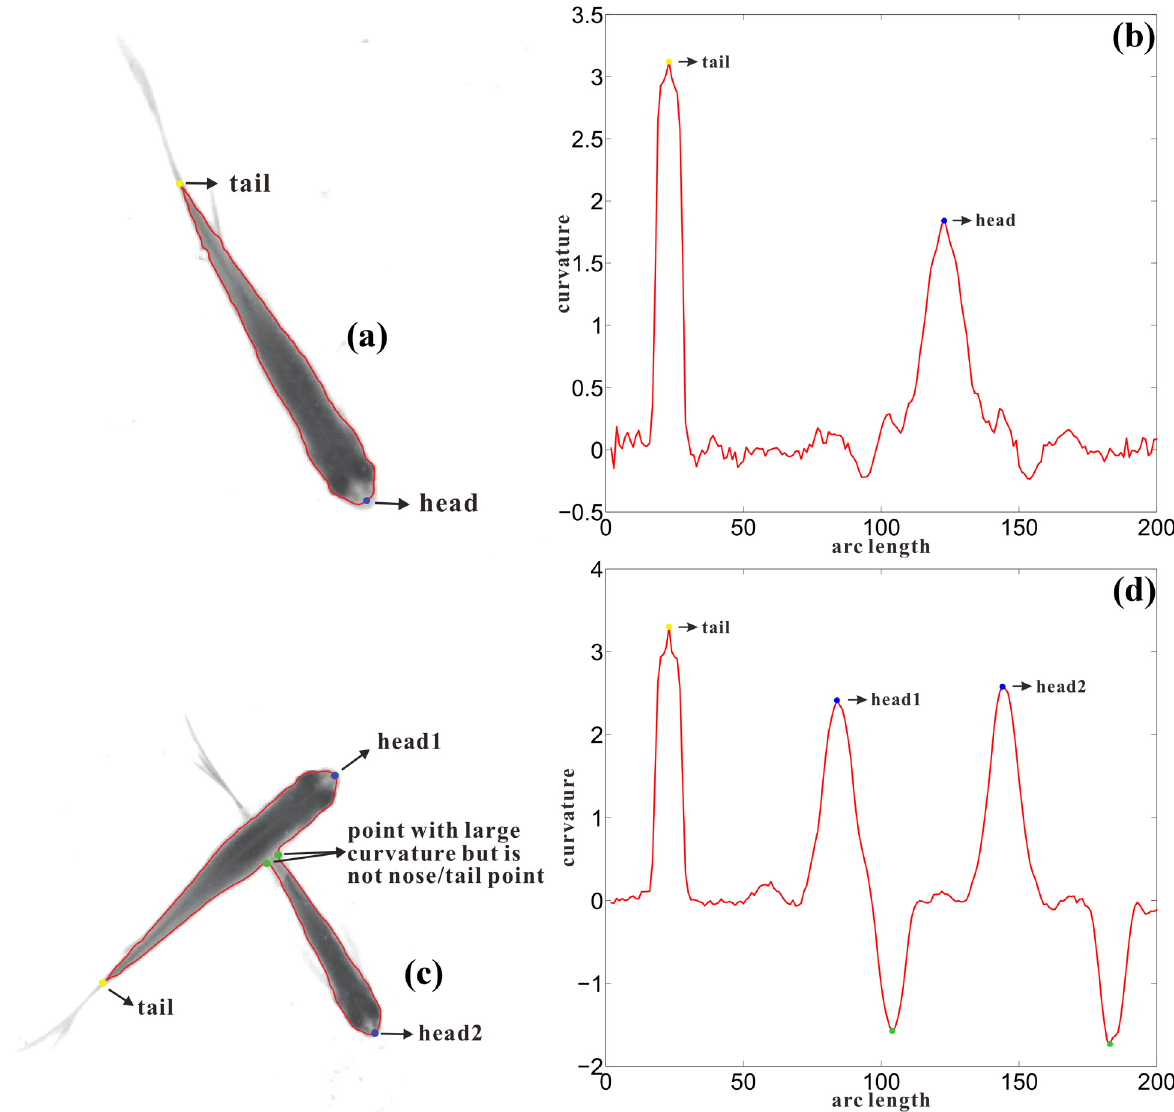
Fig 4. Fish head and tail detection. (a). Sample image of one single fish; (b). Boundary curvature curve of the fish in (a); (c). Sample image of two overlapping fish; (d). Boundary curvature curve of the two fish in (c). It can be seen that the points at intersection corner (such as the green points in (c)) won ’ t be misjudged as tail or nose points. The two green points in (c) are also plotted in the